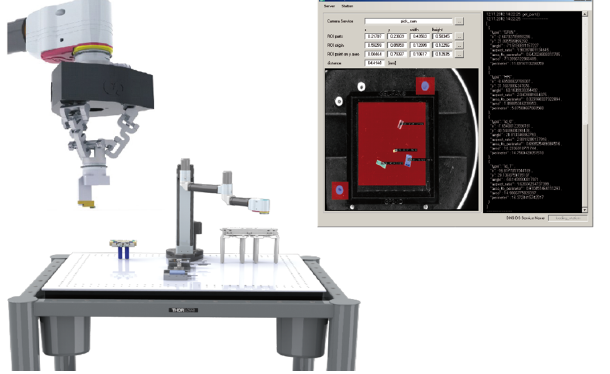
Figure 8. Hybrid assembly setup consisting of a SCARA kinematic as macro-positioner and a micromanipulator for fine alignment. The software window shows the result of image processing (detection of reference marks and localization of optics of di ff erent